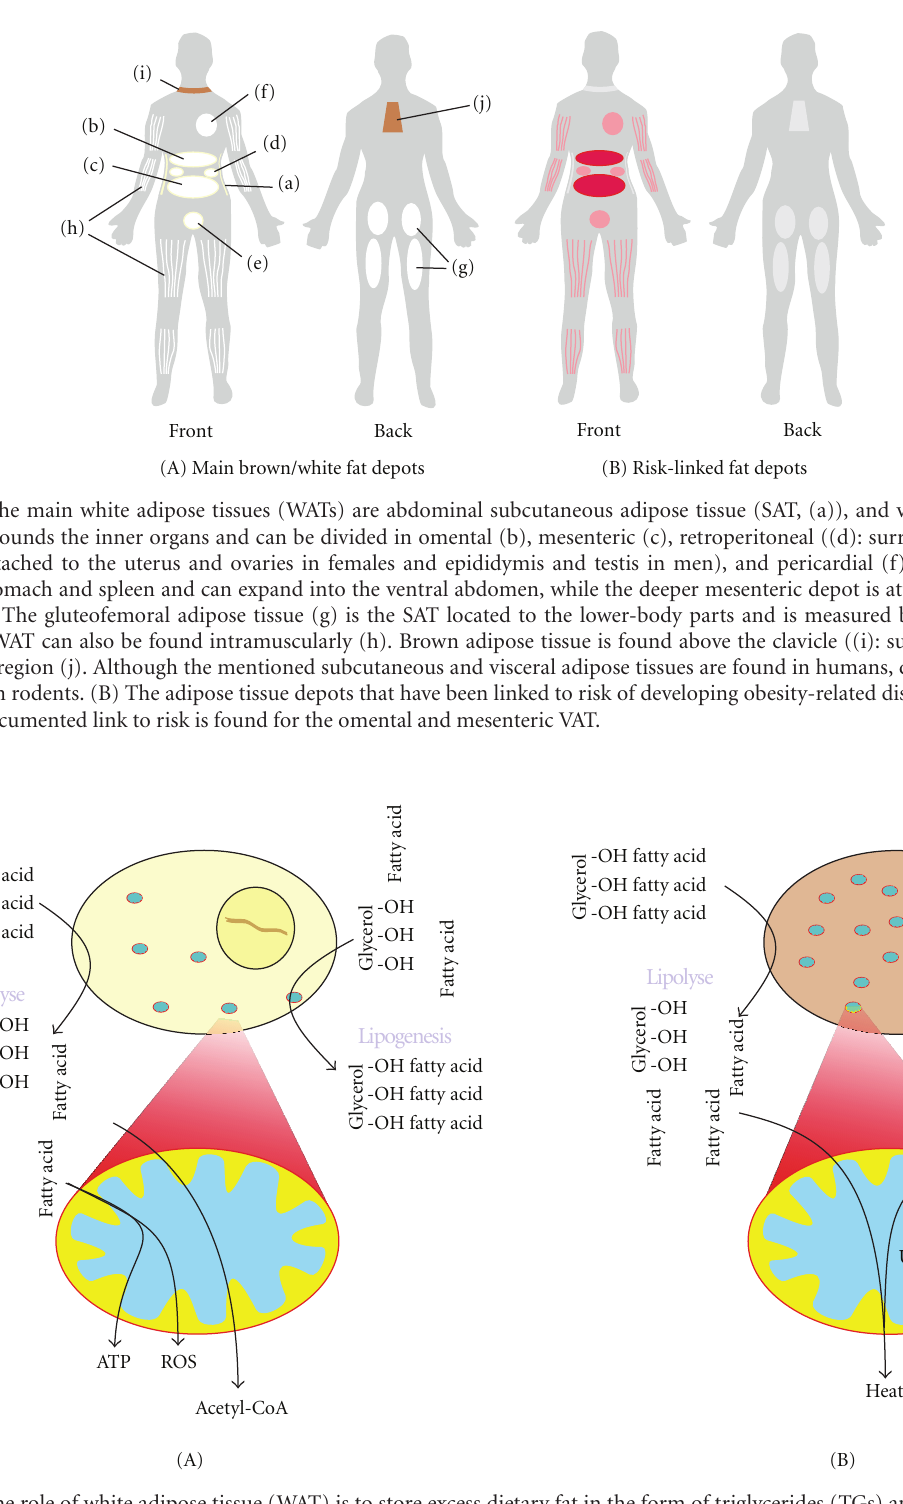
Figure 2: (A) The role of white adipose tissue (WAT) is to store excess dietary fat in the form of triglycerides (TGs) and to release free fatty acids (FFAs) in times of starvation or energy demand. In addition WAT releases several important factors that regulate energy homeostasis. Lipolysis takes place in the cytosol and is also dependent on processes in the mitochondria. The resulting FFA can be released to the blood or directly used as an energy source by β -oxidation in the mitochondria. In lipogenesis, glycerol and acyl-CoA produced in the mitochondria are used to generate TG for storage in the adipocytes. (B) In brown adipose tissue (BAT) the FFAs are β -oxidized, and the resulting acetyl-CoA enters the Krebs cycle. The reduction potential is used to form a mitochondrial proton gradient that instead of producing ATP is released by uncoupling protein 1 (UCP1), a process that generates